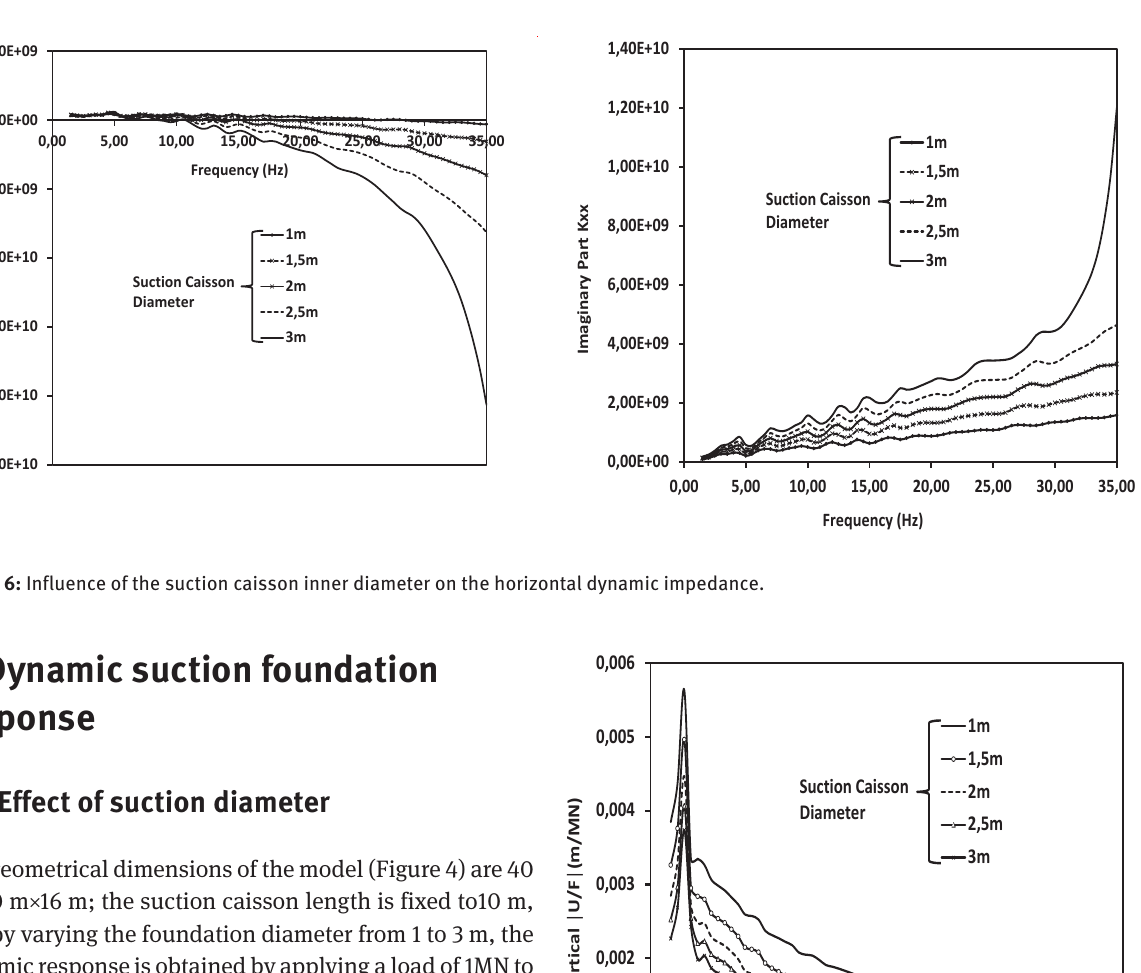
Figure 5 Influence of the suction caisson inner diameter on the vertical dynamic impedance